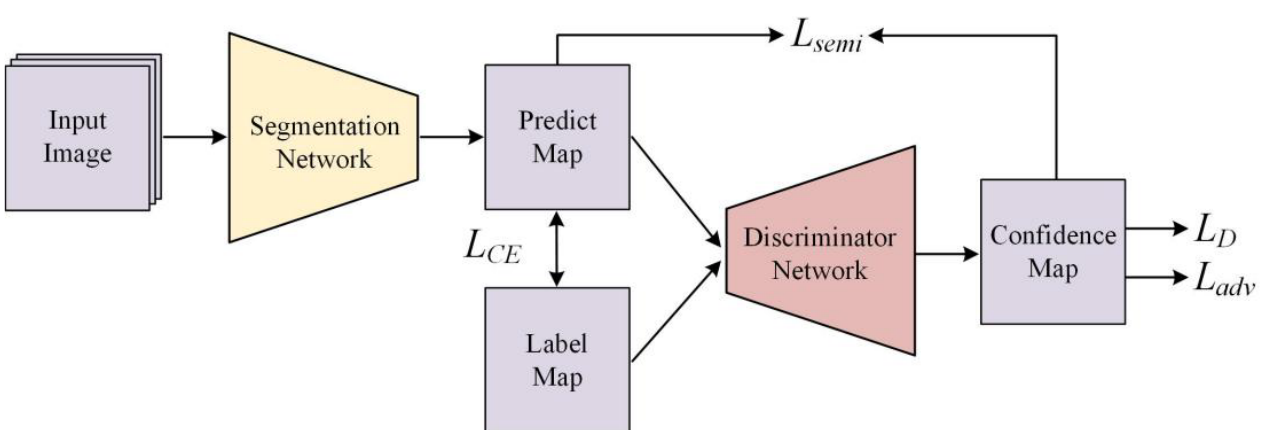
Figure 1. A typical SSAL framework, where L CE , L D , L adv and L semi respectively represent cross-entropy loss, discriminator loss, adversarial loss, and semi-supervised loss, respectively. FCNs are commonly used to construct segmentation networks and discriminator networks under the SSAL framework. FCNs have powerful feature extraction